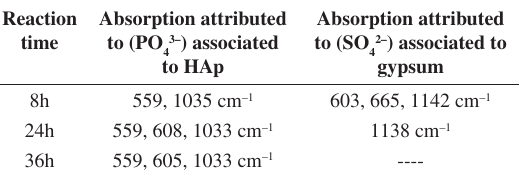
Figure 5. Infrared spectrums: A) for porous gypsum; B), C) and D) for HAp after 8, 24 and 36 hours conversion time, respectively. Table 1. Absorption regarding functional groups assigned to HAp and dihydrated gypsum.